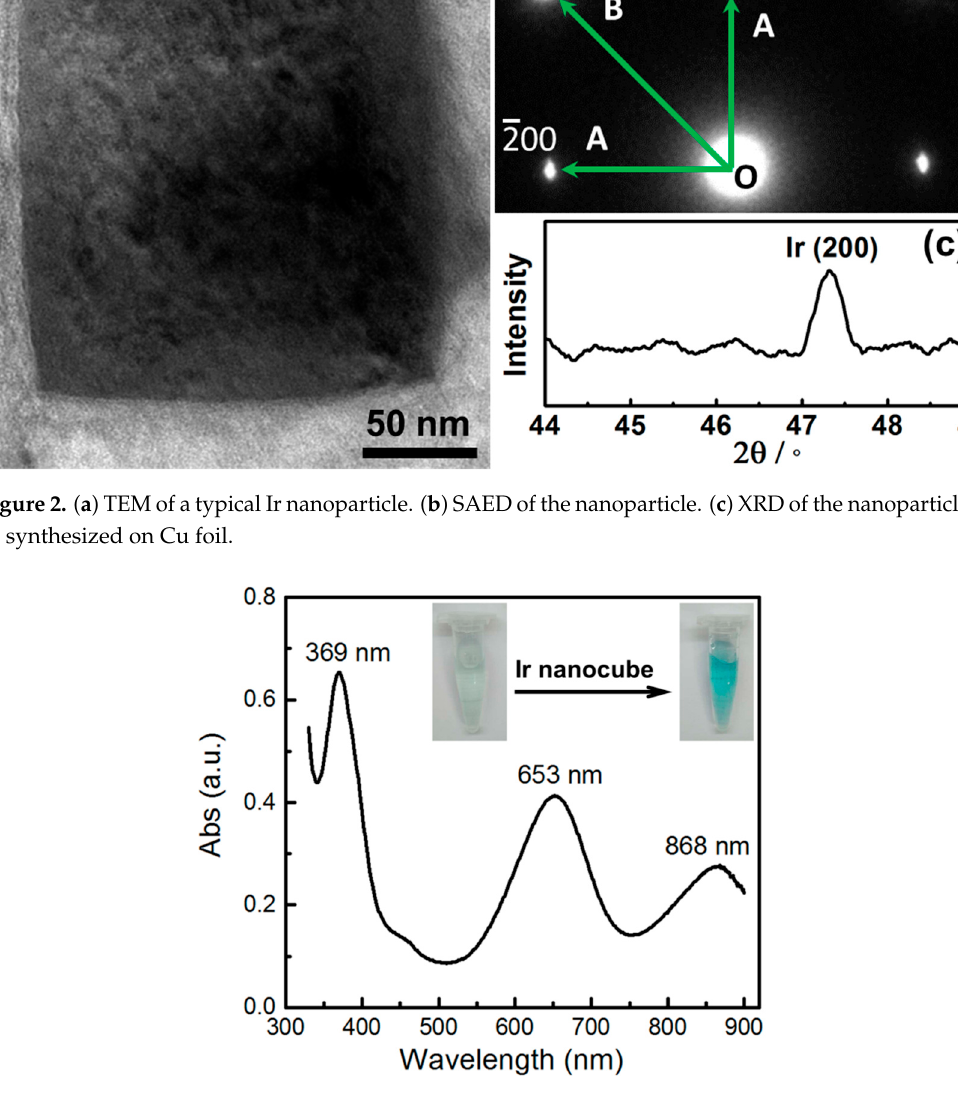
Figure 3. UV-vis spectrum characterization of TMB oxidation by H 2 O 2 catalyzed by cubic Ir nanoparticles.